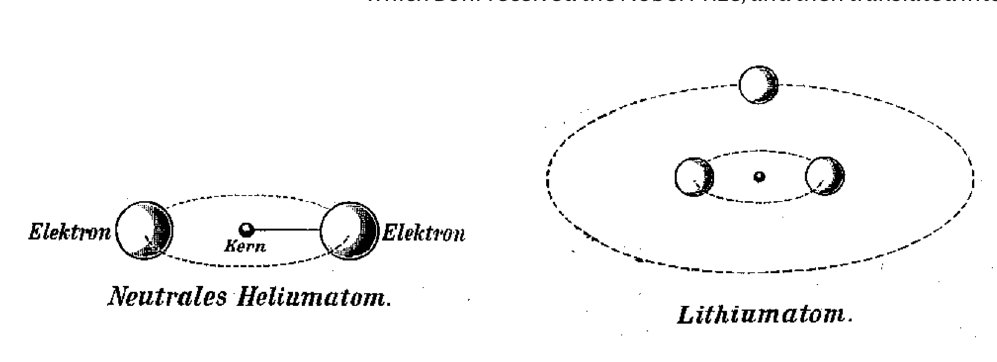
Fig. 2 The Bohr model of helium and lithium,Graetz, 1918, note